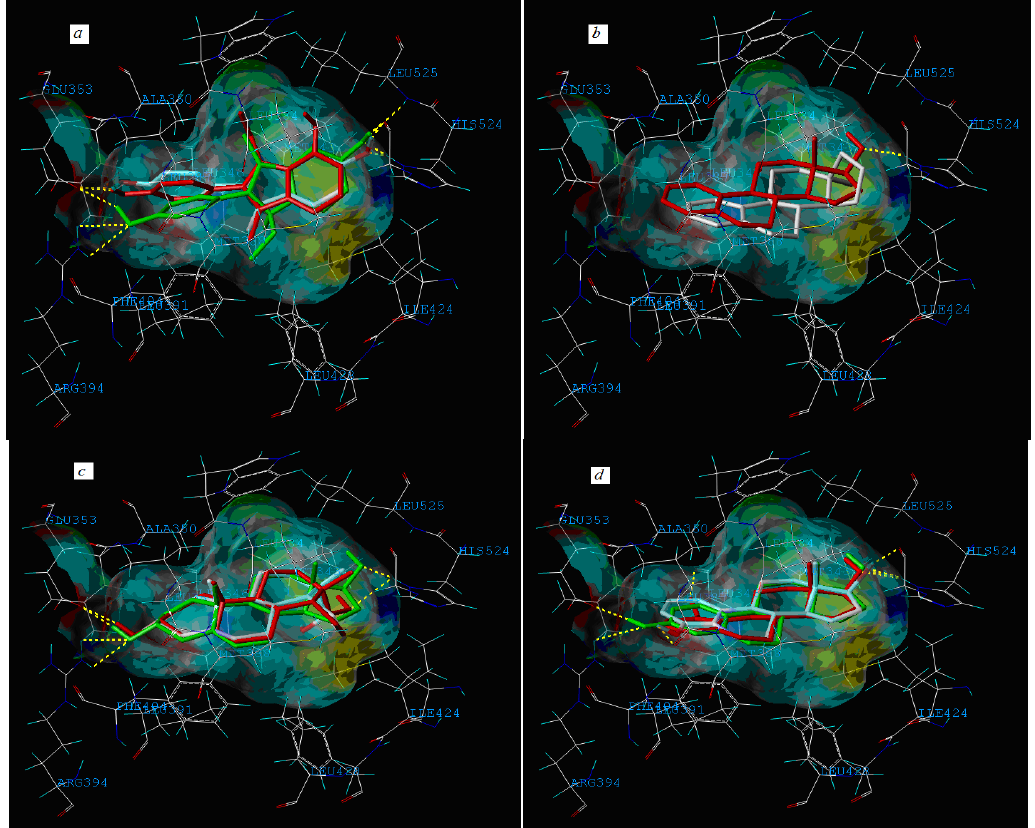
Figure 6. The interacting mode of compounds with ER α (PDB code: 1ERE). ( a ) The red is compound 37 , the green is compound 22 and the remaining one is compound 32 ; ( b ) The red is compound P08 , and the other is P09 ; ( c ) The green is P12 , the red is P13 and the remaining one is P14 ; ( d ) The green is P01 , the red is P04 and the remaining one is P06